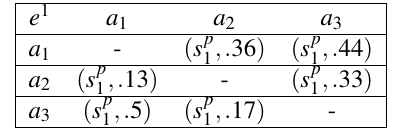
Table 9. Aggregated linguistic preference indexes for e 1 .